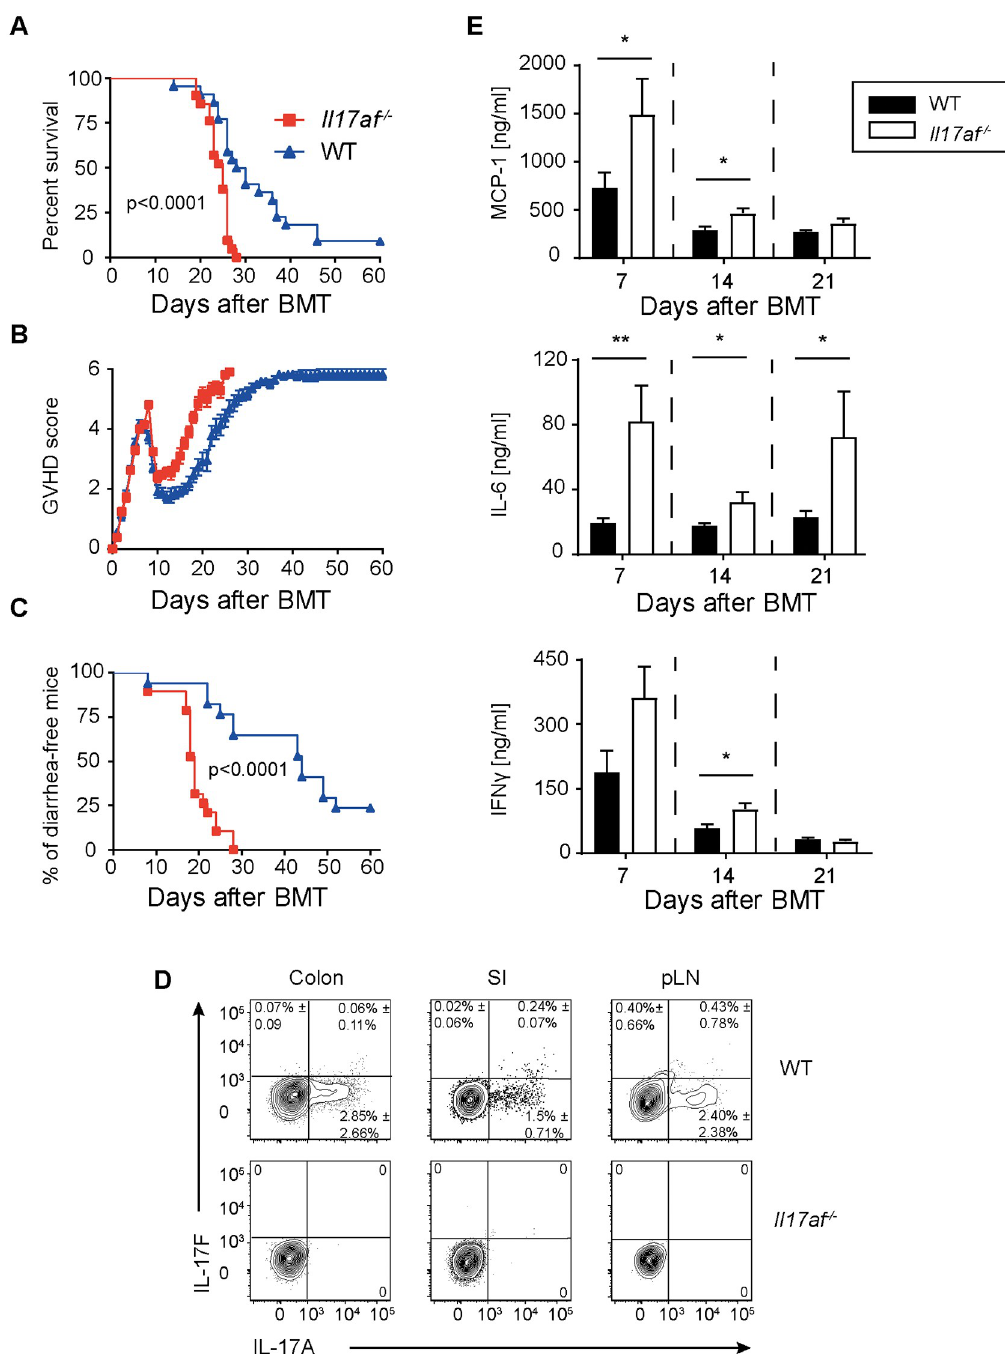
Fig 1. Deficiency of IL-17A and IL-17F in donor CD4 + T cells leads to aggravated GVHD. BALB/c mice were lethally irradiated and transplanted with 5x10 6 TCD BM and 0.5x10 6 CD4 + T cells from BL6 WT or Il17af -/- donors. A) Survival curve of Il17af -/- and WT T cell recipients. Data are pooled from four independent experiments ( Il17af -/- n = 21, WT CD4 + cells n = 22). For statistical analysis the log rank test was used. B) Clinical score. C) Percentage of diarrhea-free mice. D) FACS sorted donor Thy1.1 + CD4 + T cells were analyzed for the expression of IL-17A and IL-17F. Donor WT or Il17af -/- CD4 + T cells were isolated from BALB/c recipients from colon, SI and pLNs on day 21 after BMT. Data were collected from three independent experiments for colon and SI (WT n = 10, Il17af -/- n = 11); and two experiments pLNs (WT = 8, Il17af -/- n = 7). E) Concentrations of IL-6, MCP-1 and IFN γ cytokines in the sera of WT or Il17af -/- CD4 + T cell recipients sacrificed at day 7, 14, and 21 after BMT. (day 7 WT n = 10, Il17af -/- n = 10; day 14 WT n = 11, Il17af -/- n = 12; day 21 WT n = 16, Il17af -/- n = 15). Statistical significance was determined by Student’s t test. The bars show the mean and error bars show SEM. https://doi.org/10.1371/journal.pone.0231222.g001 PLOS ONE | https://doi.org/10.1371/journal.pone.0231222 April 6,